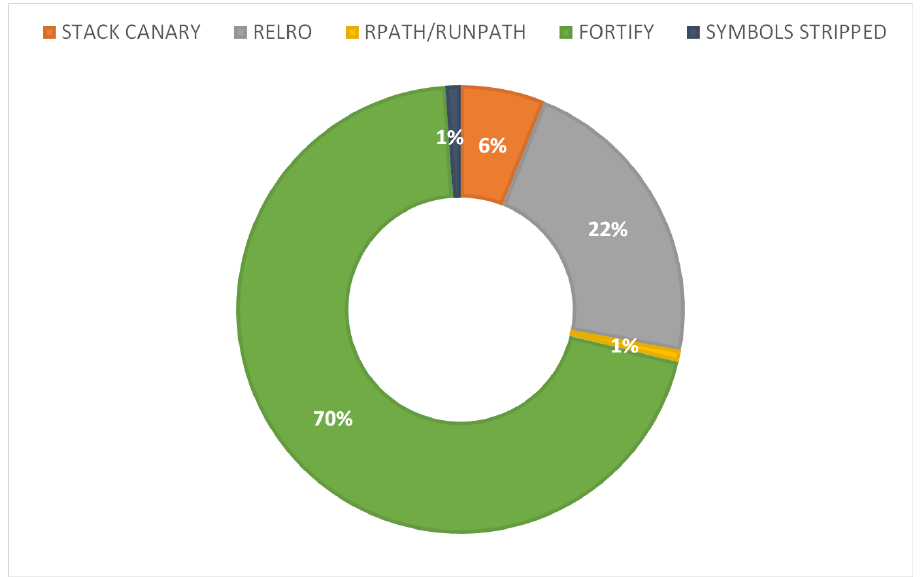
Figure 5. Breakdown of shared library issues. The NX value is insignificant, i.e., less than 0.5%, and it is not included in the